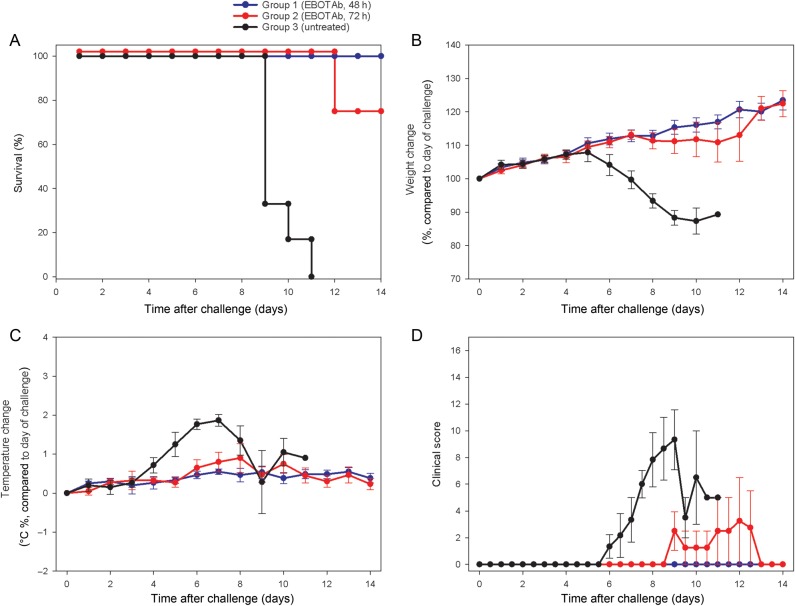
Survival and clinical overview of guinea pigs treated with EBOTAb 48 and 72 hours after challenge. Guinea pigs were challenged with Ebola virus (EBOV), and 25 mg of EBOTAb was administered intravenously in a volume of 0.5 mL 48 hours (group 1) or 72 hours (group 2) after challenge. EBOTAb was administered daily until day 7, followed by treatment every 2 days until day 11. Untreated animals (group 3) received no compound. A, Survival analysis between the EBOTAb-treated groups and untreated animals. B, Weight changes, showing percentage differences from values on the day of challenge. C, Temperature differences in animals, compared with baseline, on the day of challenge. D, Clinical scores of animals after challenge. In panels B–D, mean results are shown of animals still surviving in all groups, with error bars denoting standard errors.